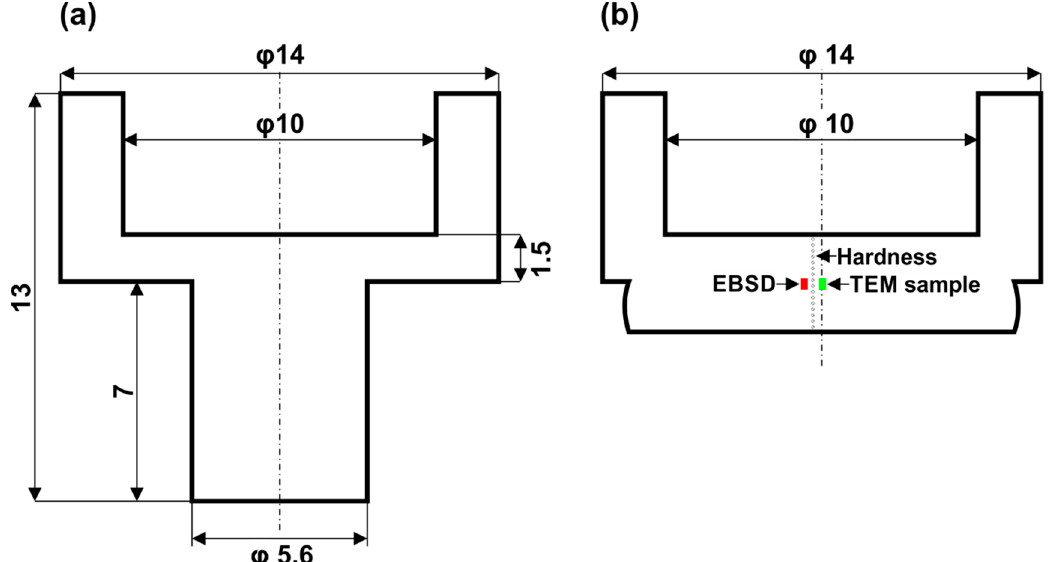
Figure 3. Dimensions of the sample ( a ) prior deformation; ( b ) after deformation. The deformed samples were then sectioned along the compression axis for a micro- 116 A focused ion beam (FIB) technique was used to prepare the TEM samples. For this purpose, samples were cut towards the compression direction at a position that was 1/2 away from the surface toward the center of the sample. Samples were then analyzed in the transmission electron microscope JEM 3010UHR from JEOL at an accelerating voltage of 200